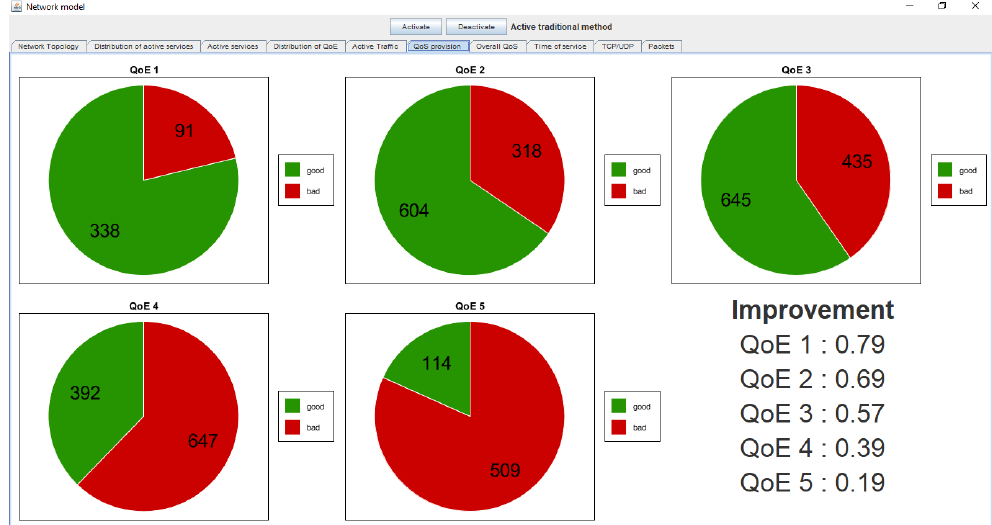
Figure 25. Customers QoE in the network with active traditional method.